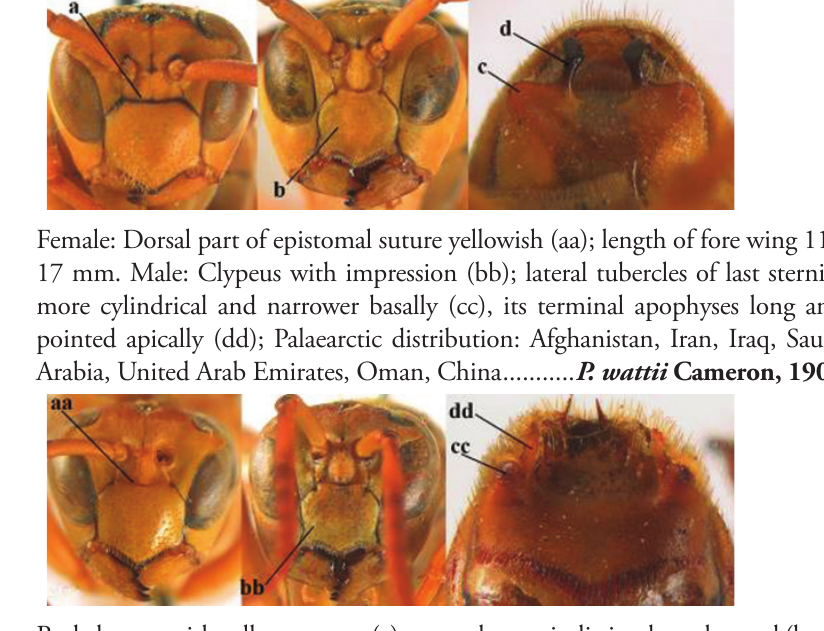
3 Body brown with yellow pattern (a); mesopleuron indistinctly sculptured (b, c); recently introduced to northern Spain, native to South and Central America, Caribbean islands and southern U.S.A. (subgenus Aphanilopterus ) .................... ................................................................ P. major Palisot de Beauvois, 1818